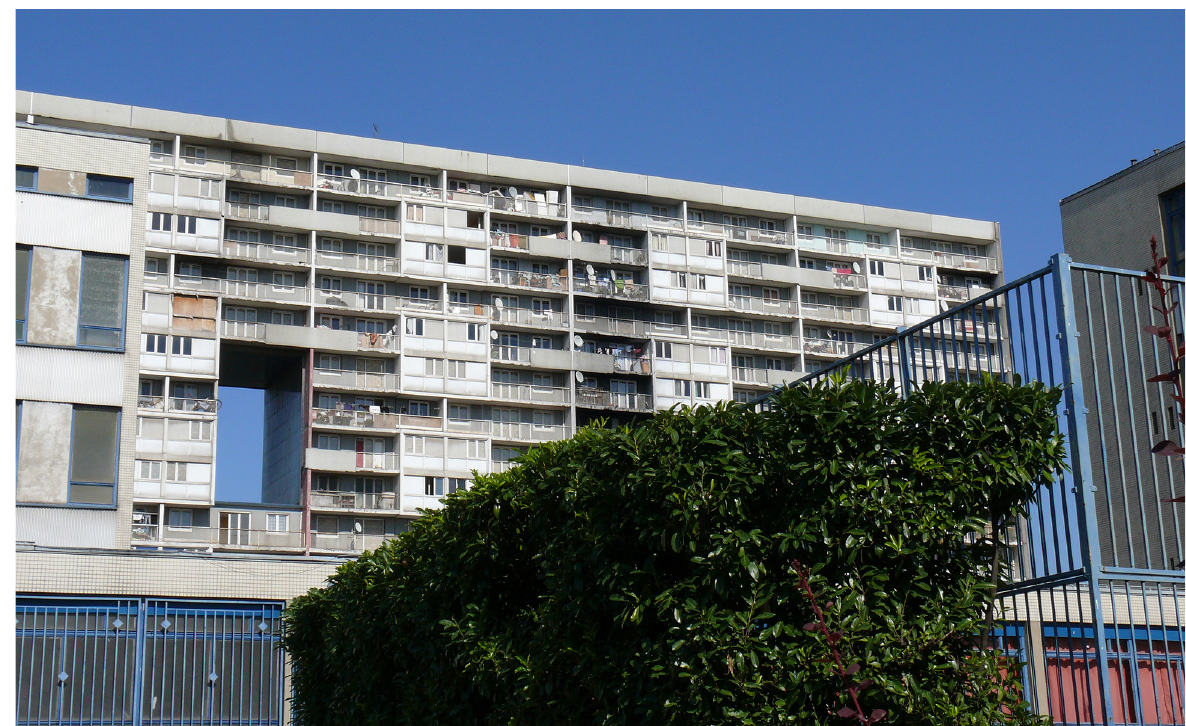
Fig. 2. ‘Balzac’, a high-rise block (now demolished) in the ‘ Cité des 4000’ , la Courneuve (northern rim of Paris) – a synonym for poverty and drug dealing. Photo by Florian Weber